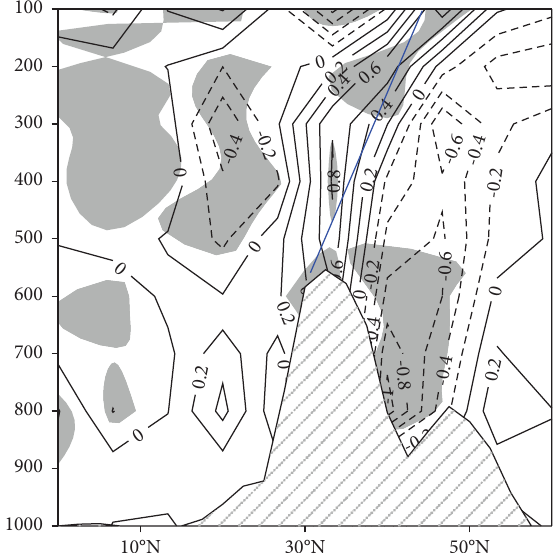
Figure 7: Diference synthetic feld of the height-latitude section of temperature gradient along 97.5 ° C of strong AHS/weak westerly- monsoon year and weak AHS/strong westerly-monsoon year (unit: ° C, shadow indicates passing 95% reliability signifcance test, slashes area represent terrain).